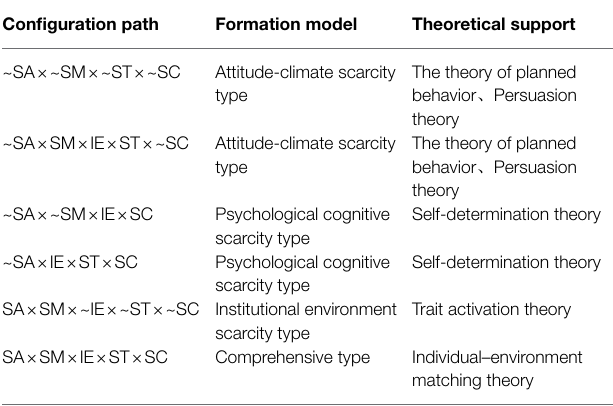
TABLE 11 | Formation mode and theoretical summary of high and non-high result configurations. Configuration